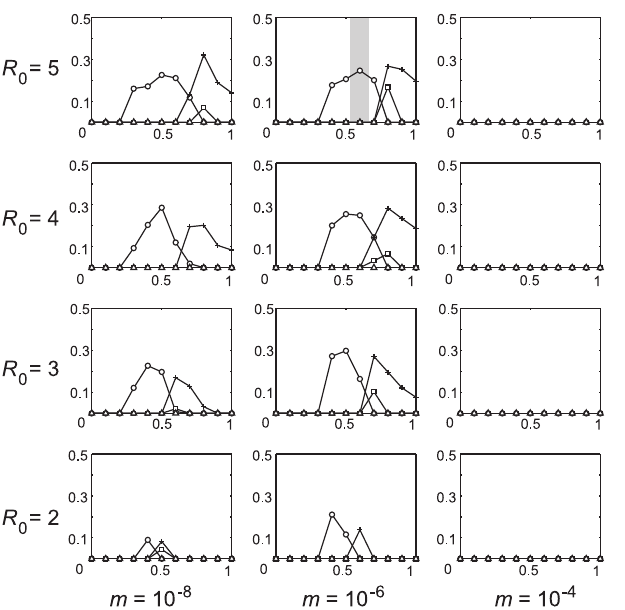
Figure 1. Qualitative Accuracy Measure q for the Performance of Four Models Qualitative accuracy measure (vertical axis) is shown in dependence on the cross-immunity coefficient s (horizontal axis), the transmission coefficient R 0 (rows), and the mutation probability m (columns). Each panel shows the performance of four models: Gog and Grenfell’s model (circles), order-1 independence closure (pluses), order-1 interpolation closure (squares), and order-2 independence closure (triangles). The highlighted region indicates the parameter combination m ¼ 10 (cid:4) 6 , R 0 ¼ 5, and s ¼ 0.6, for which the system’s dynamics are shown in Figure 3.